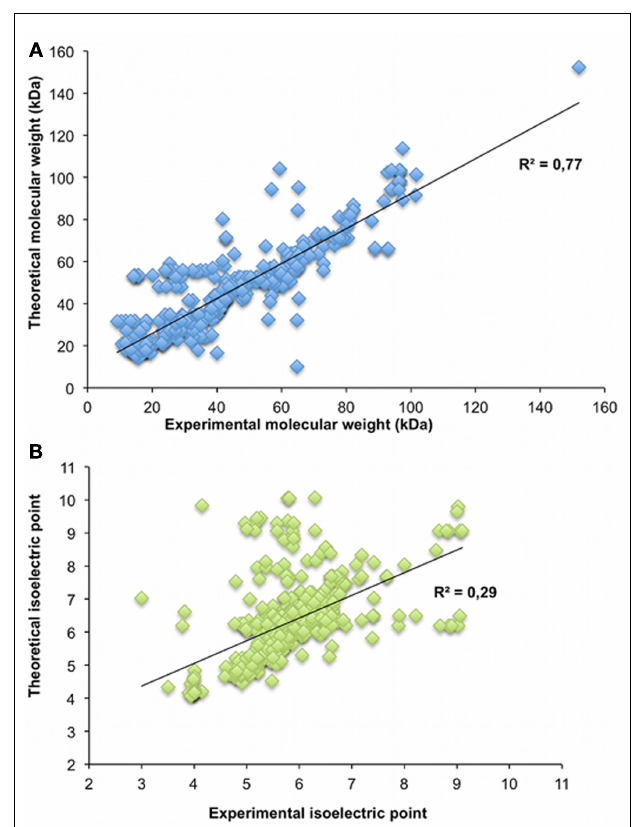
FIGURE 3 |Theoretical and observed molecular weight and isoelectric points. The theoretical and observed molecular weights (A) as well as the theoretical and observed isoelectric point (B) from 457 protein spots with a unique AGI-ID are plotted. For both linear regressions, the correlation coefficient is indicated on each